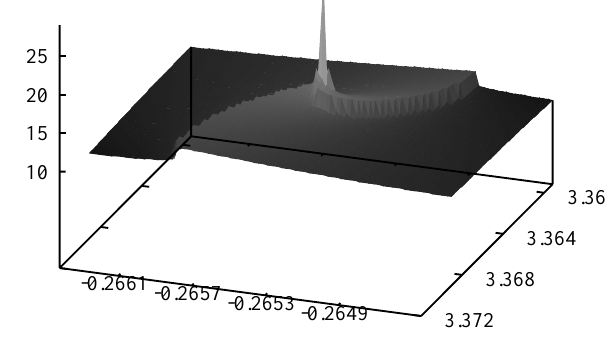
Figure 1. Profile of the x m versus the parameters a 2 and A . The peak position indicates the best approximation of the solution of the nonlinear Eq. (18) in non-rotational fluid.